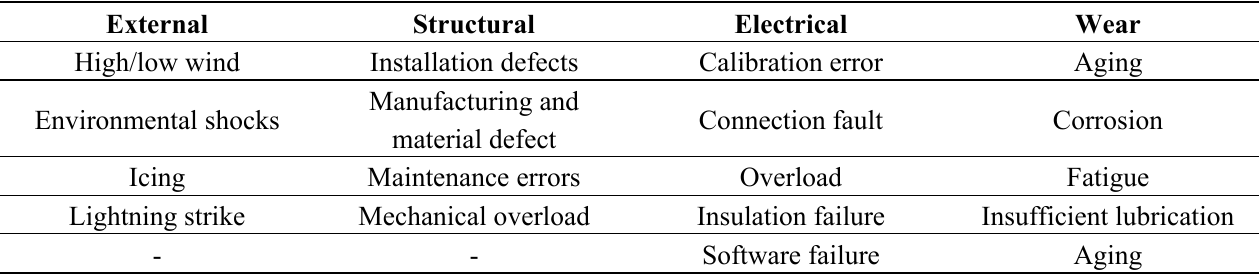
Table 6. Root causes of the failure modes in wind turbine systems.